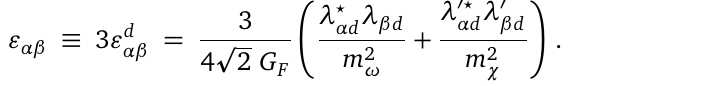
Table 7.1 summarizes the maximum allowed tree-level NSI in each flavor for all type-I radiative neutrino mass models. See Ref. [ 151 ] for more